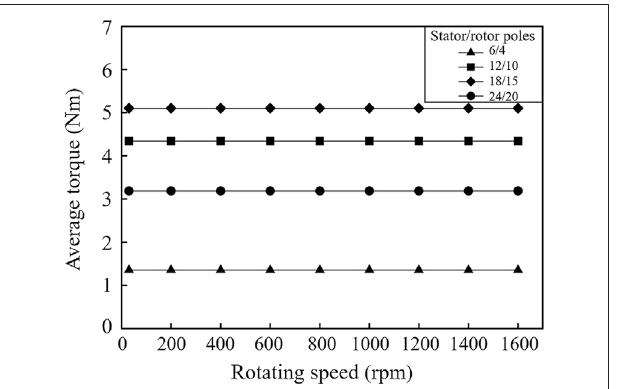
FIGURE 8 | Average torque of all proposed DSPM structures at various rotating speed (2 A load